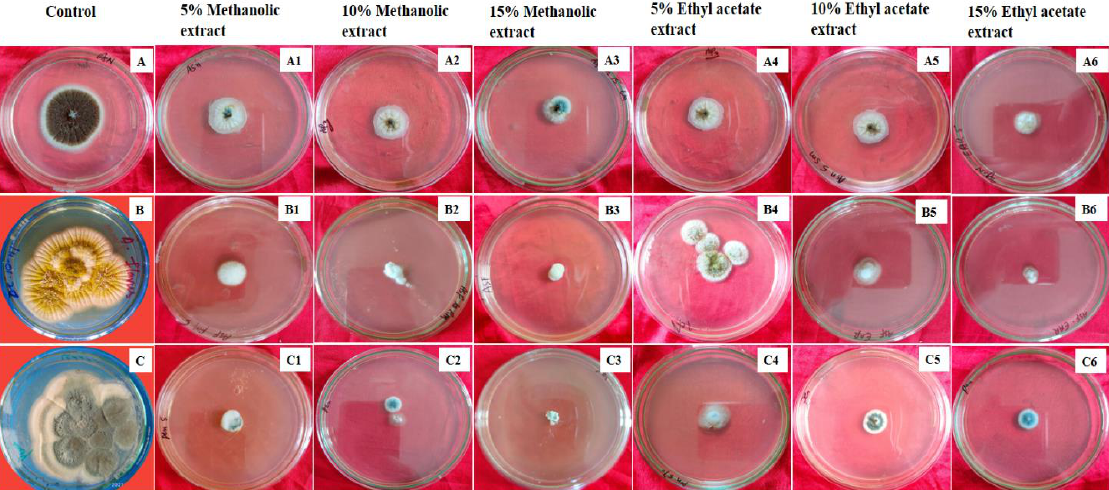
Figure 5. Inhibition of mycelia growth in Aspergillus niger , Aspergillus flavus and Penicillium notatum by methanolic extract (ME) and ethyl acetate extracts (EAEs) at 5%, 10% and 15% after five days of incubation. ( A ) Control Aspergillus niger , ( B ) control Aspergillus flavus and ( C ) control Penicillium notatum . ( A1 – A3 ) Inhibition of mycelia growth in Aspergillus niger by 5%, 10% and 15% methanolic extracts, respectively. ( B1 – B3 ) Inhibition of mycelia growth in Aspergillus flavus by 5%, 10% and 15% methanolic extracts, respectively. ( C1 – C3 ) Inhibition of mycelia growth in Penicillium notatum by 5%, 10% and 15% methanolic extracts, respectively. ( A4 – A6 ) Inhibition of mycelia growth in Aspergillus niger by 5%, 10% and 15% ethyl acetate extracts, respectively. ( B4 – B6 ) Inhibition of mycelia growth in Aspergillus flavus by 5%, 10% and 15% ethyl acetate extracts, respectively, and ( C4 – C6 ) inhibition of mycelia growth in Penicillium notatum by 5%, 10% and 15% ethyl acetate extracts, respectively.